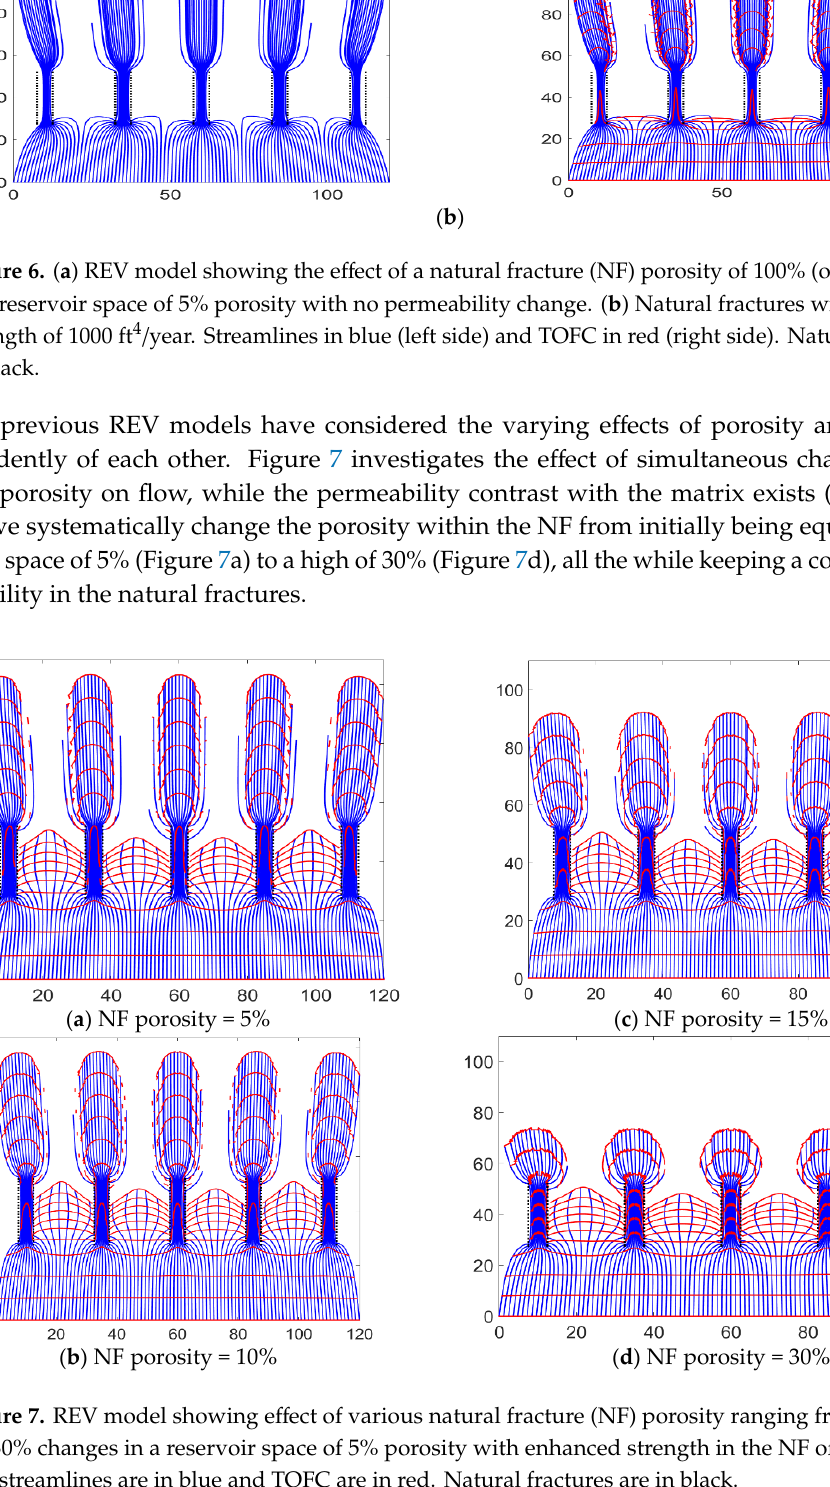
Figure 6. ( a ) REV model showing the effect of a natural fracture (NF) porosity of 100% (open fracture) in a reservoir space of 5% porosity with no permeability change. ( b ) Natural fractures with increased strength of 1000 ft 4 /year. Streamlines in blue (left side) and TOFC in red (right side). Natural fractures in black.